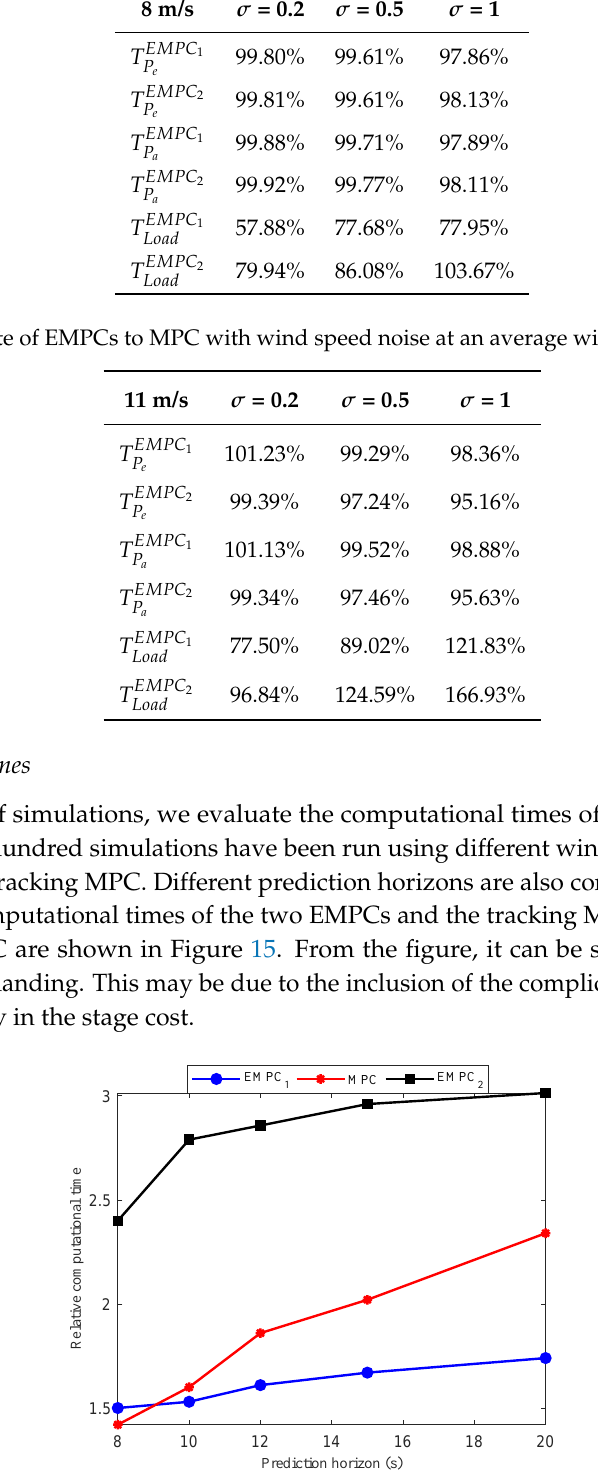
Table 8. The rate of EMPCs to MPC with wind speed noise at an average wind speed of 8 m/s.